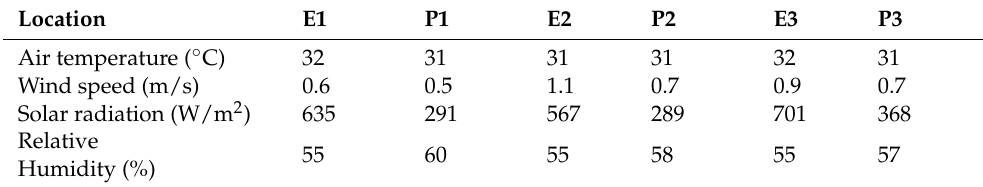
Table 3. ENVI-met results.